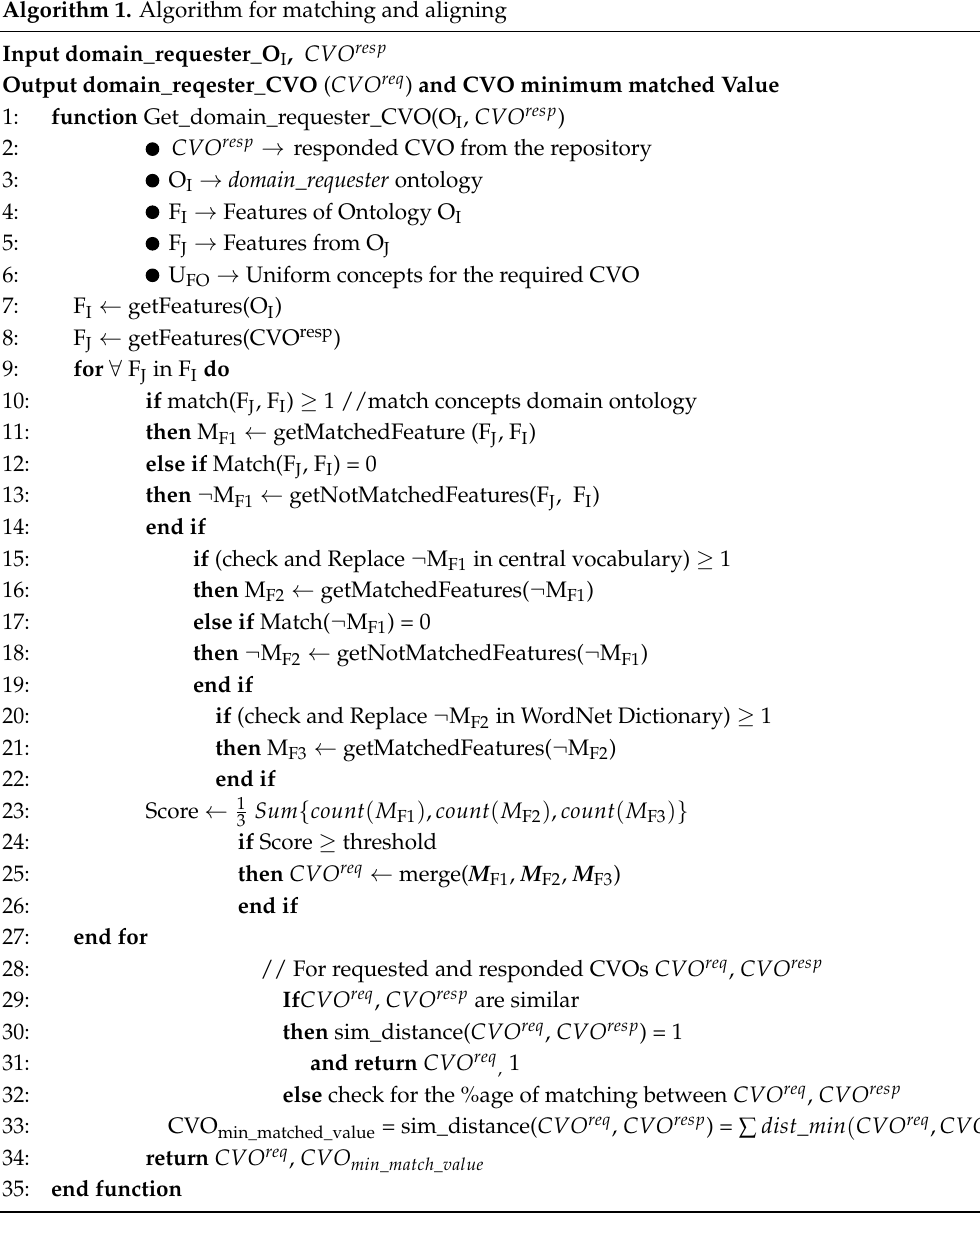
Algorithm 1. Algorithm for matching and